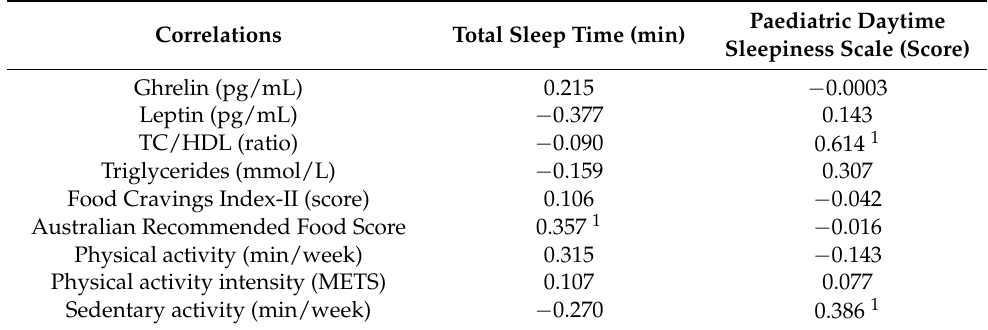
Table 5. Correlations between key sleep variables and metabolic, dietary, and physical activity markers in children with and without